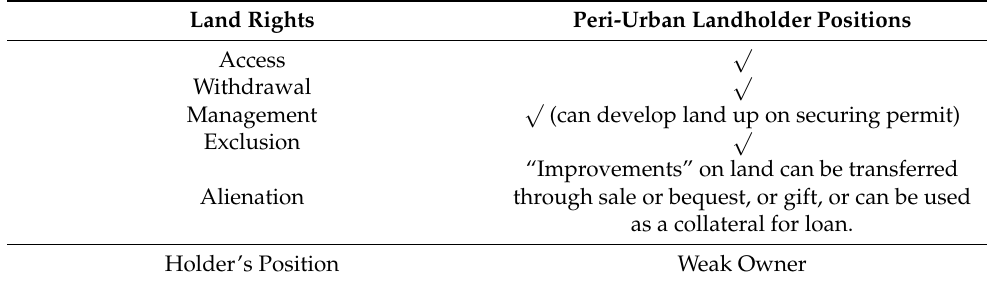
Table 4. Chefe qebel é peri-urban landholder positions. Land Rights